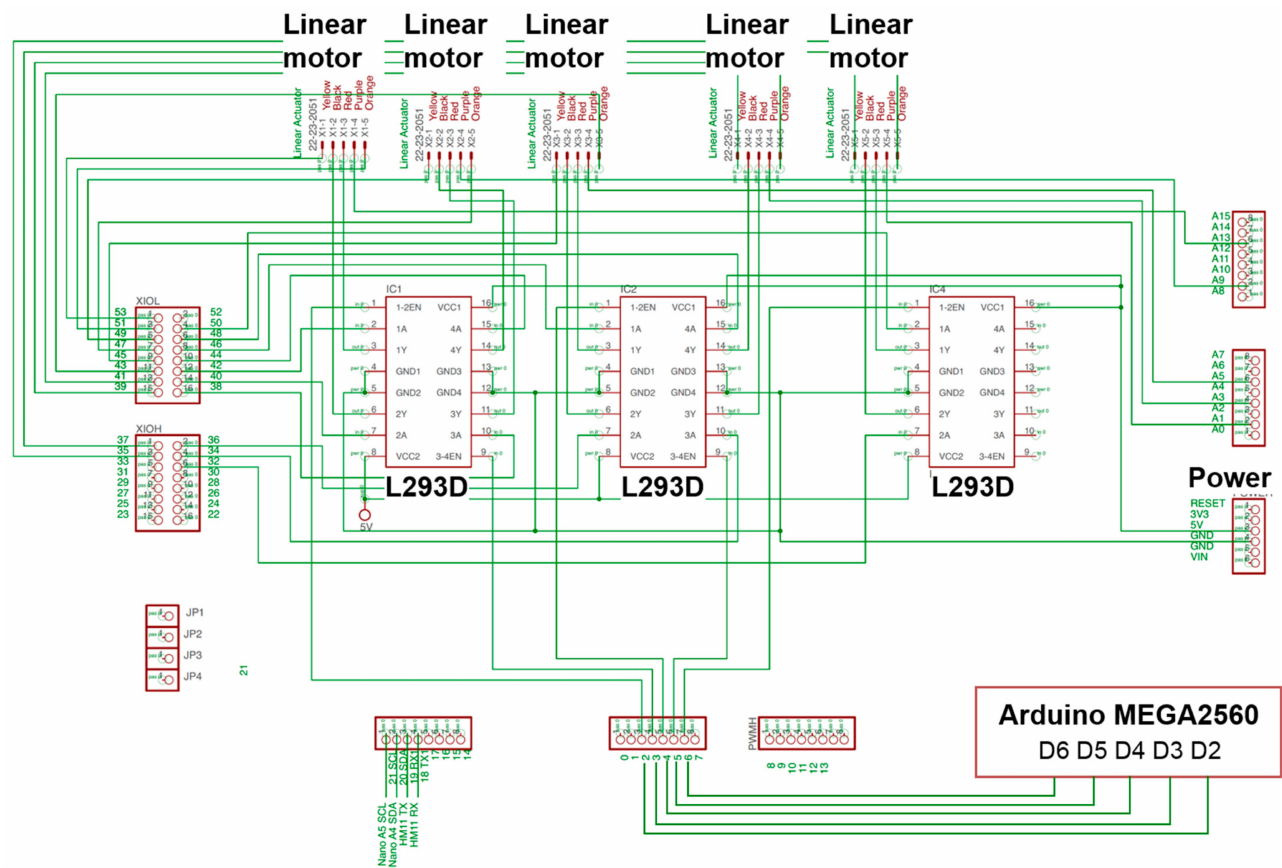
Figure 4. Electronic circuit of hand